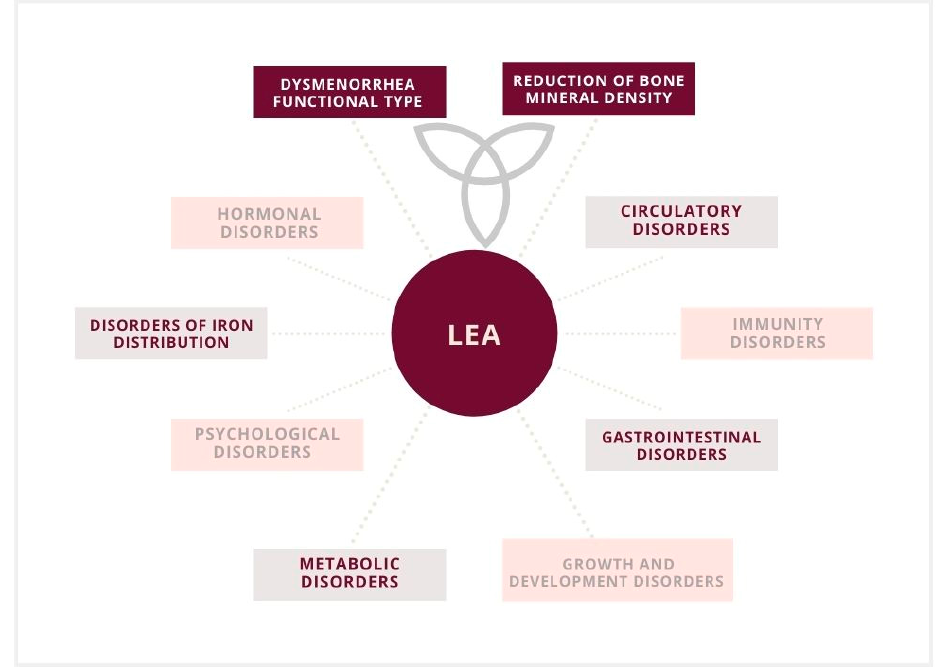
Figure 3. Low energy availability (LEA) and implications in a female athlete triad, including the functional type of dysmenorrhea and a reduction in bone mineral density.